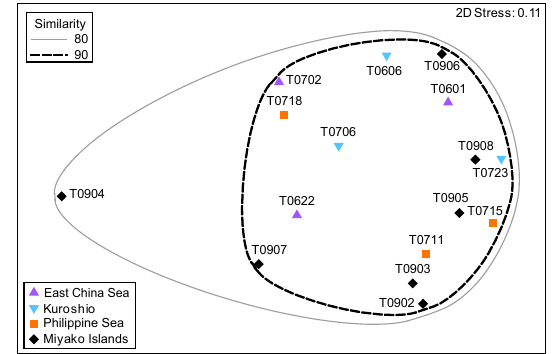
Figure 5. nMDS ordination of sampling stations with environmen- tal variables.